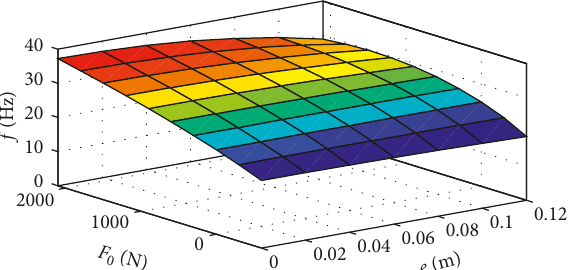
0 Figure 11: Natural frequency f of the beam with laterally fixed ends in the parameter space of F 0 and e in accordance with equation (30). Table 3: Natural frequency f of the beam with laterally fixed ends by ANSYS mechanical APDL and Approach 2. e 0 h 2 h F 0 APDL App. 2 equation (30) Dev. (%) APDL App. 2 equation (30) Dev. (%) APDL App. 2 equation (30) Dev. (%) −